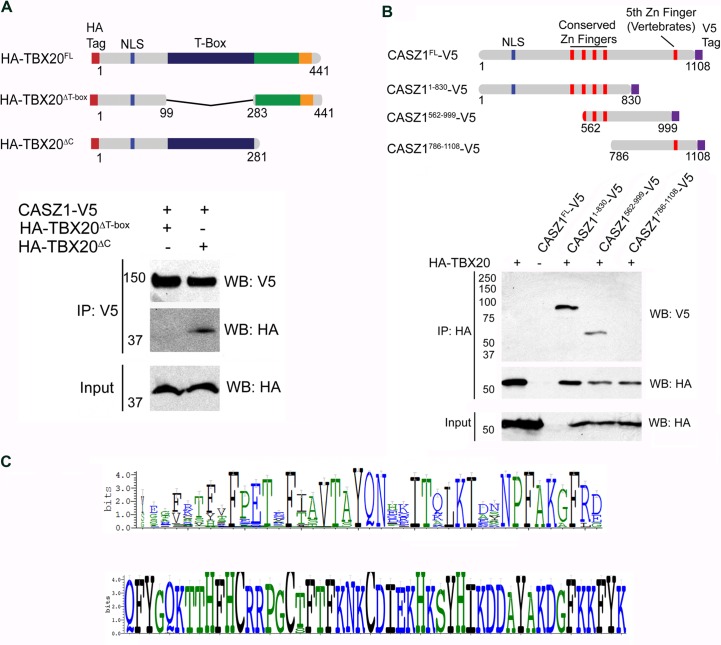
TBX20 and CASZ1 interact through their DNA binding domains.(A) (Top) Schematic of full-length TBX20 and truncations. NLS, Nuclear Localization Signal. Putative activation domain shown in green and putative repression domain in orange. (Bottom) Co-immunoisolations from X. laevis embryos expressing full-length CASZ1-V5 and either full-length HA-TBX20 or deletions shown in top panel. (B) (Top) Schematic of full-length CASZ1 and the truncations used in the co-immunoisolations. (Bottom) Co-immunoisolations from X. laevis embryos expressing full-length HA-TBX20 alone, or in combination with either full-length CASZ1-V5 or truncations shown in top panel. (C) (Top) Sequence alignment of TBX20 position 248–288 across 90 TBX20 orthologs. Height of letters is relative to conservation at that residue. (Bottom) Sequence alignment of CASZ1 at positions 601–650 across 90 CASZ1 orthologs.